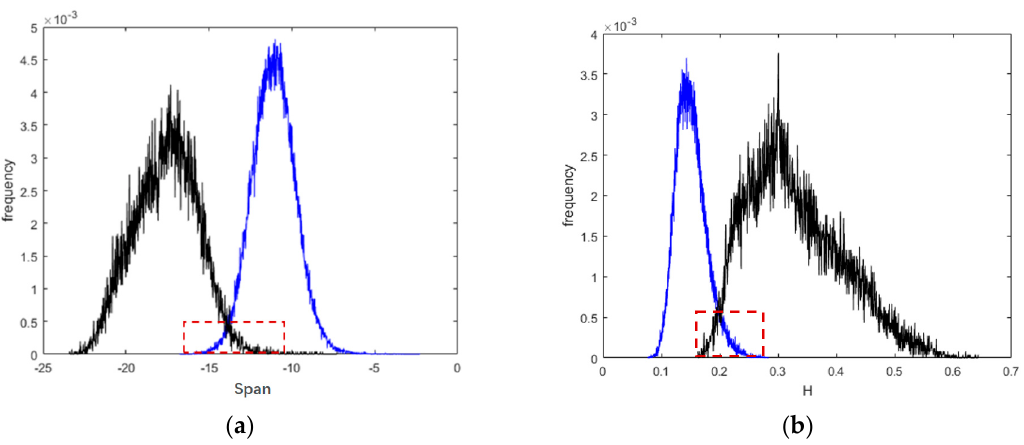
Figure 5. Probability density of ocean oil spill and water in region of interesting in one dimensional feature space: ( a ) span ; and ( b ) H .